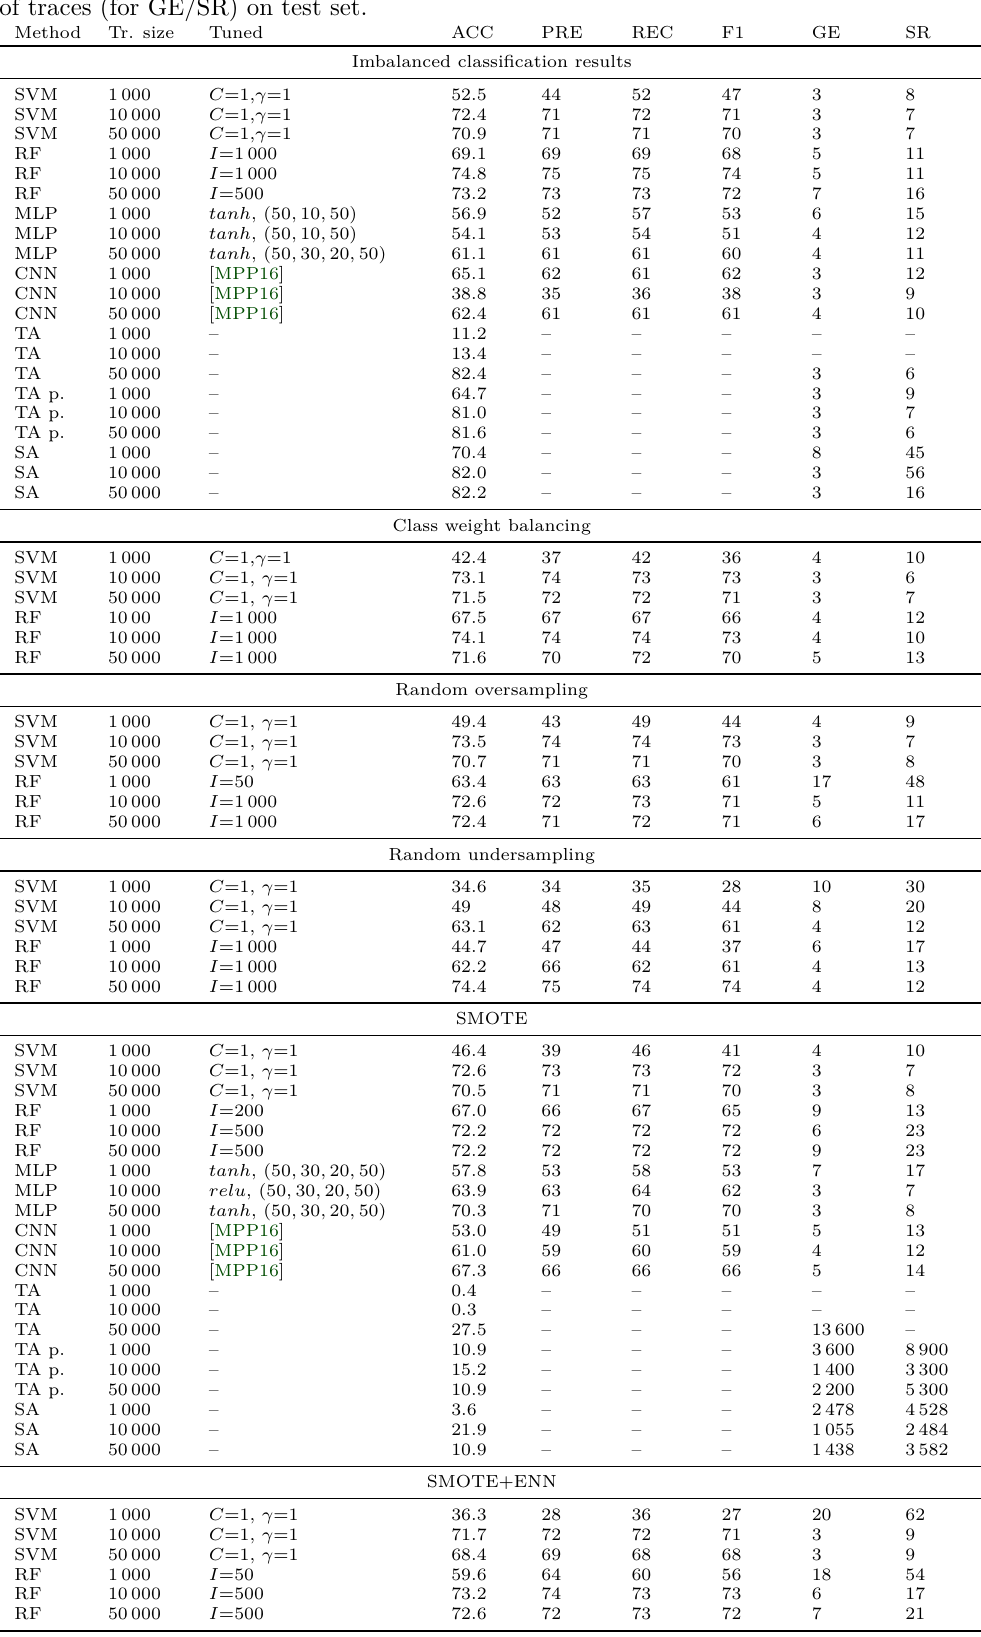
Table 5: DPAcontest v4 dataset. Values are given as percentages (ML metrics) and number of traces (for GE/SR) on test